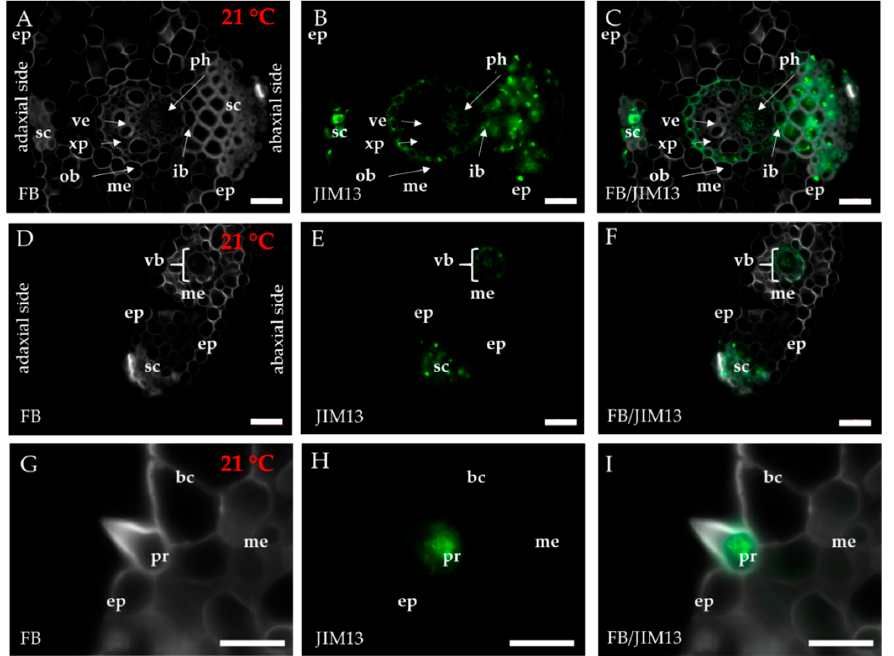
Figure A2. Immunolocalisation of the JIM13 epitope ( A – I ) in cross ‐ sections of B. distachyon leaves (21 °C), ( A – C ): through the major vascular bundle; ( D – F ): through the edge of the leaf blade; ( G – I ): prickle. The white arrows point to the respective parts of the leaf. Abbreviations: bc—bulliform cells, ep—epidermis, FB—fluorescent brightener, ib—inner bundle sheath, me—mesophyll, ob—outer bundle sheath, ph—phloem, pr—prickle, sc—sclerenchyma, vb—vascular bundle, ve—vessels, xp—xylem parenchyma. The green colour shows epitope occurrence. Scale bars: 20 μ m.